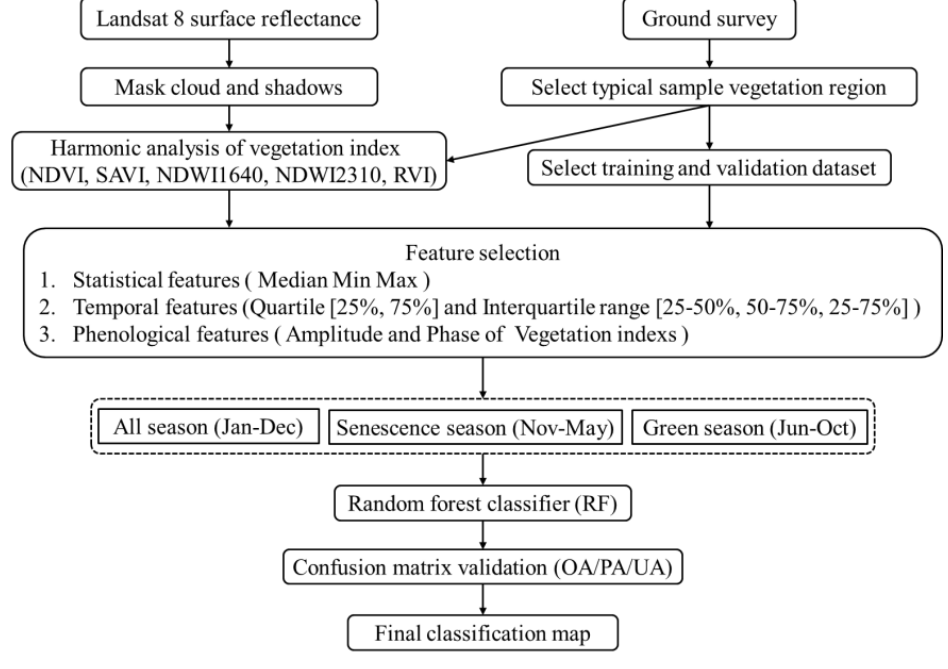
Figure 2. Experimental flowchart. Table 1. Characteristics of the Landsat 8 Operational Land Imager (OLI) images used in the experiment.